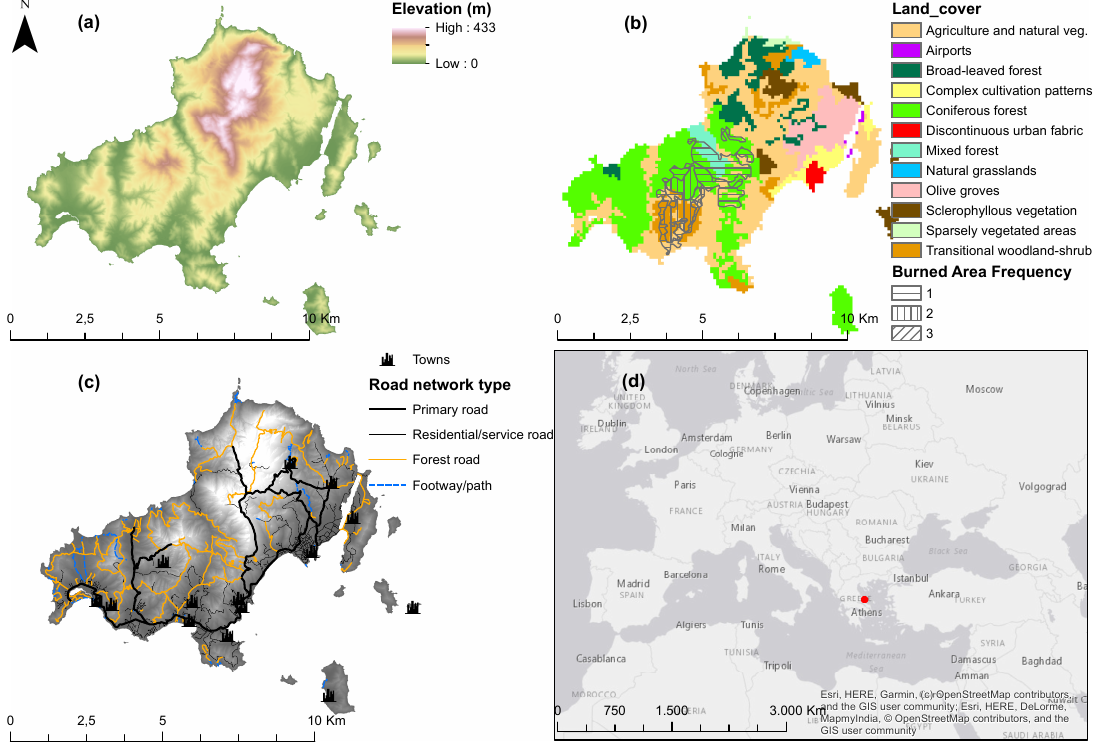
Figure 1. ( a ) Elevation, ( b ) land cover and burned areas, ( c ) spatial distribution of road and human settlements network, and ( d ) geographical position of Skiathos